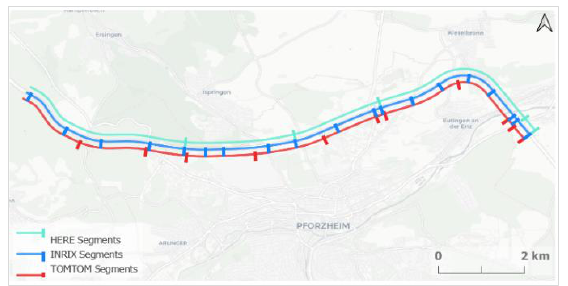
Figure 2: HERE, INRIX and TomTom road segments on the A8 highway. The line geometries have been offset for easier visualization and comparison of their varying lengths.